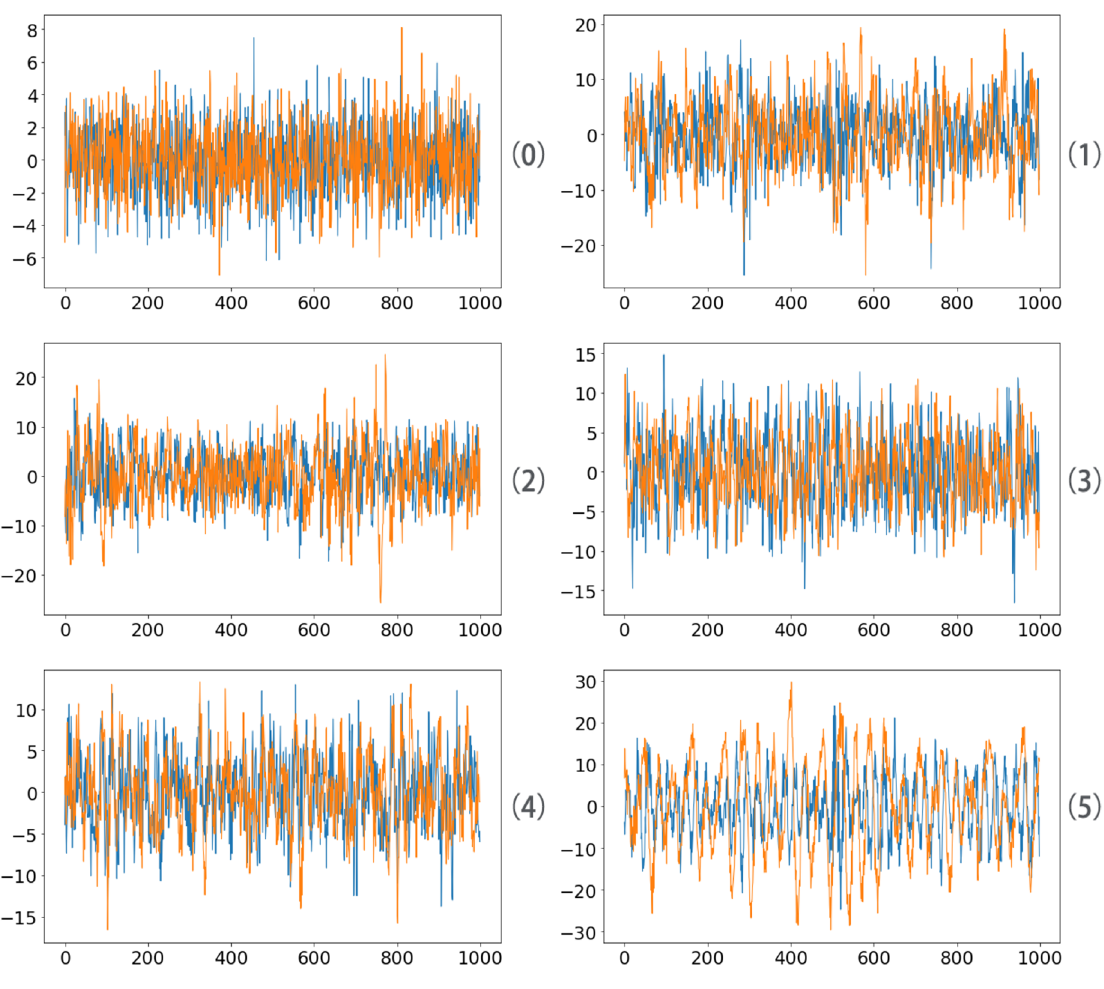
Figure 14. Fault bearing vibration data waveform.